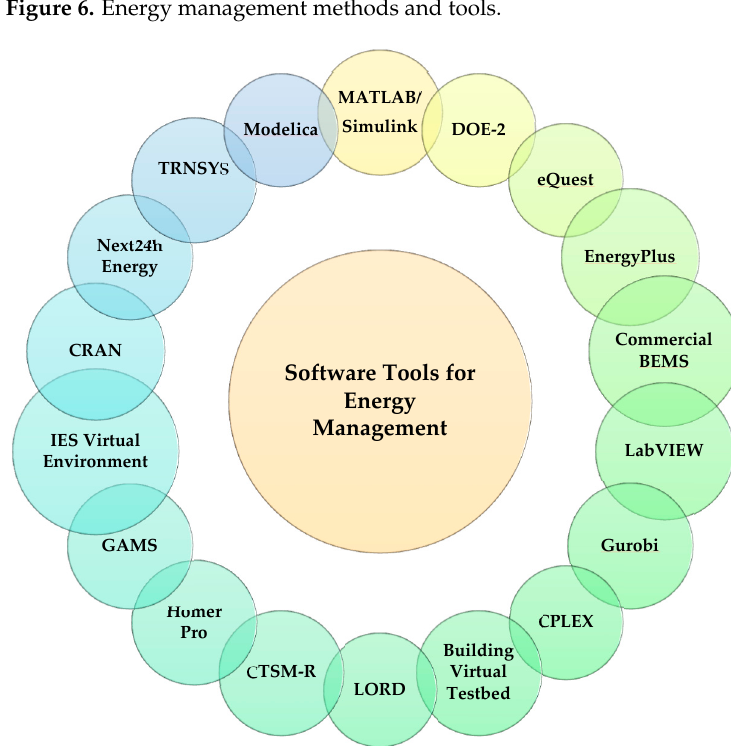
Figure 7. Software tools commonly used for energy management .